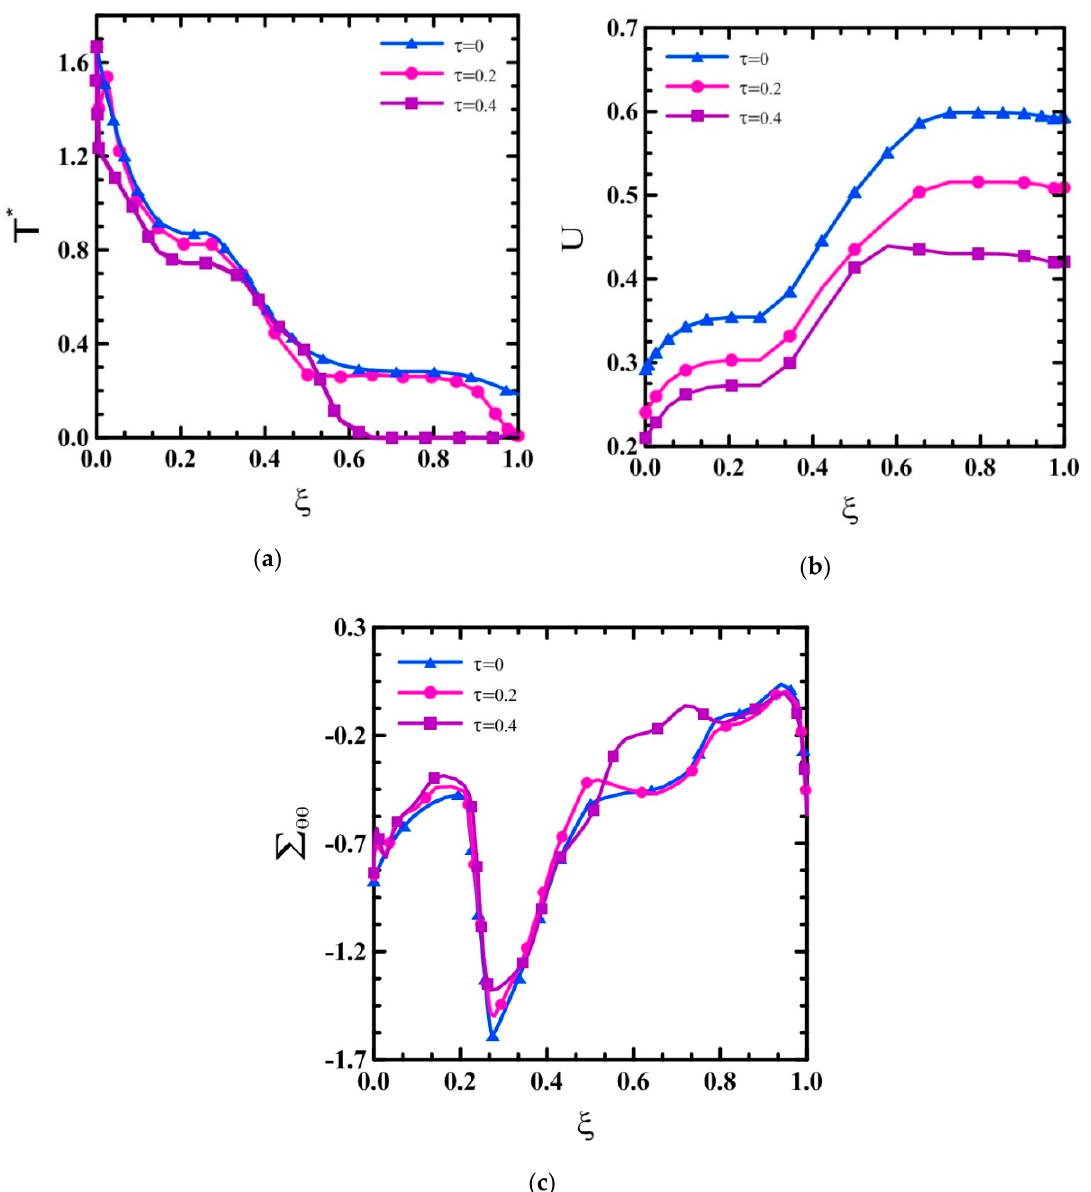
Figure 7. ( a – c ): Effect of the relaxation time on the distribution of the thermoelastic field variables through the radial direction for the FG cylindrical panels with piezoelectric layers ( ) (cid:16) (cid:17) p = 1, h c / h p = 5, θ 0 = 75 ◦ , ψ = 0.03, θ = 0.5 θ 0 , F 0 = 0.8 . 0 0 The through-the-thickness heat wave propagation and the resulting variations in the mechanical field variables of the FG cylindrical panels with piezoelectric layers are shown in Figure 9a–c for di ff erent non-dimensional time levels F o . The results clearly demonstrate that the model can simulate thermoelastic wave propagation in multilayer panels. It is worth observing that the temperature and the radial displacement increase with an increasing dimensionless time F o